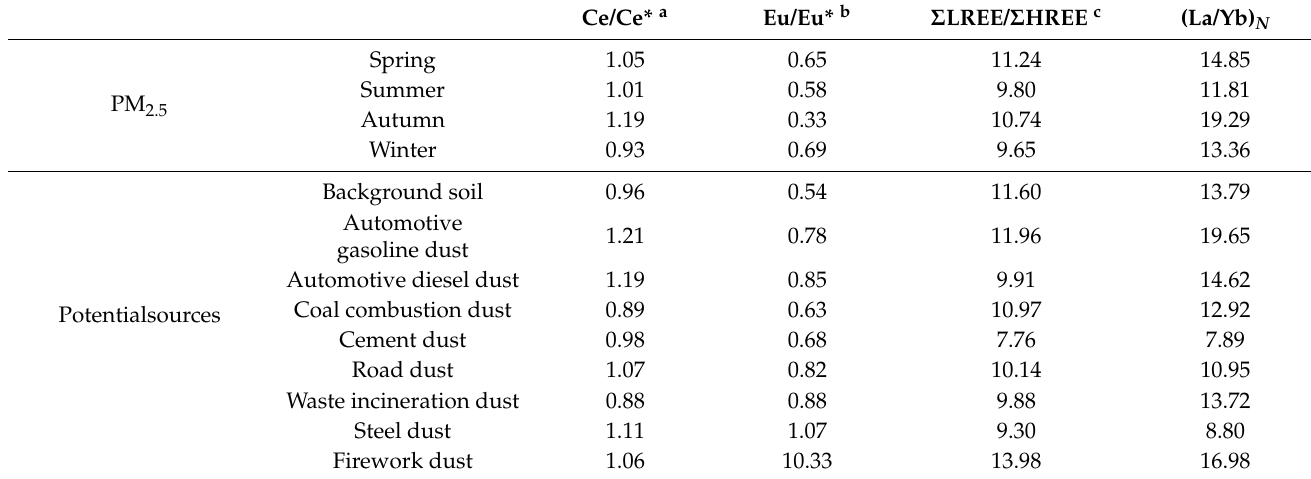
Table 2. Characteristic parameters of REEs in PM 2.5 and potential sources in Xiamen